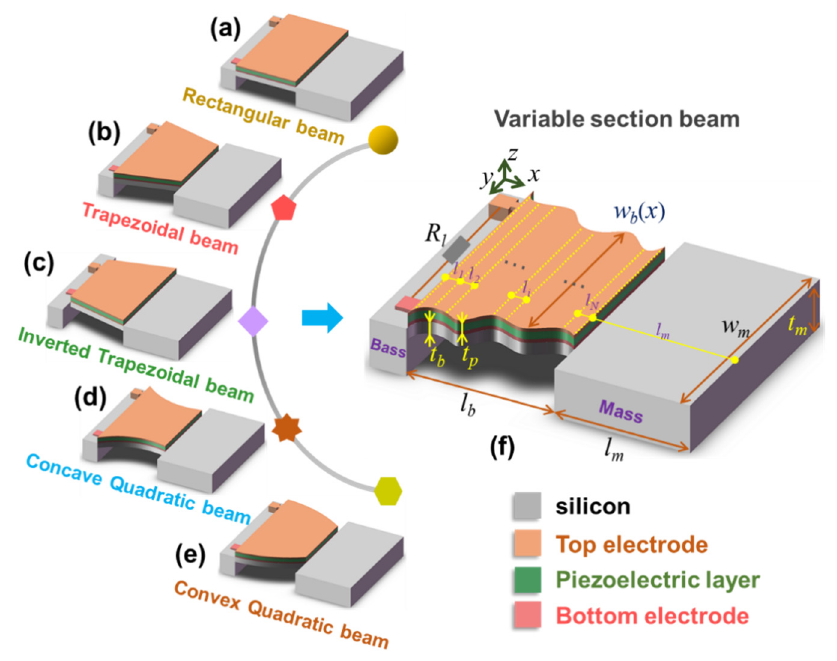
Figure 1. Structure diagrams of several common MEMS variable cross-section cantilever beam based piezoelectric vibration energy harvesters, ( a ) rectangular beam type, ( b ) trapezoidal beam type, ( c ) inverted trapezoidal beam type, ( d ) concave quadratic beam type, ( e ) convex quadratic beam type, and ( f ) variable section beam type.